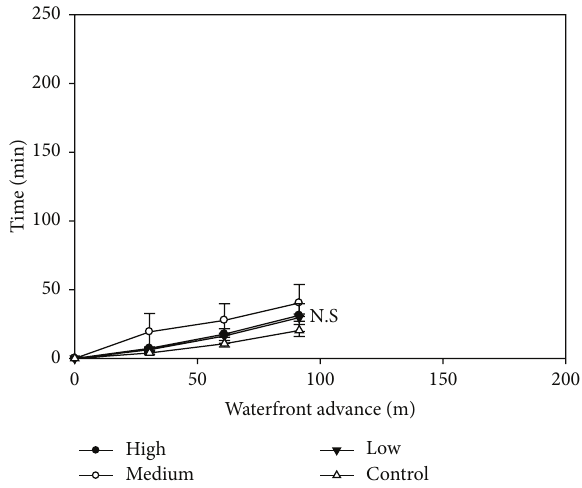
Figure 3: The waterfront advance time for the 274 m long field at varying locations from the inflow end. The error bars represent the standard error. The High, Medium, Low, and Control residue treatments represent varying amounts of residue biomass in the furrow. Means represented by symbols with same letters are not significantly different ( 𝑃 < 0.05 ). NS: nonsignificant